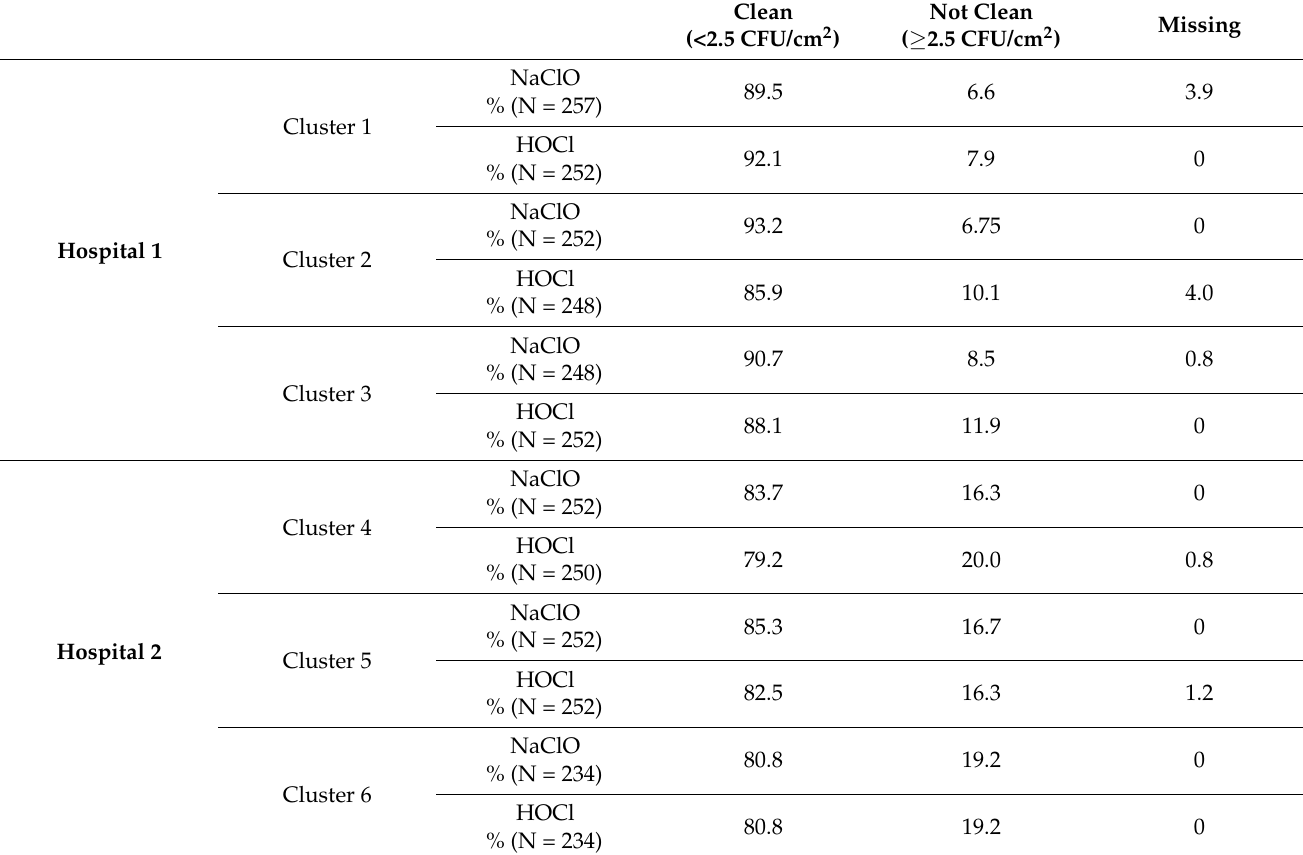
Table 2. Distribution of cleanliness by hospital and